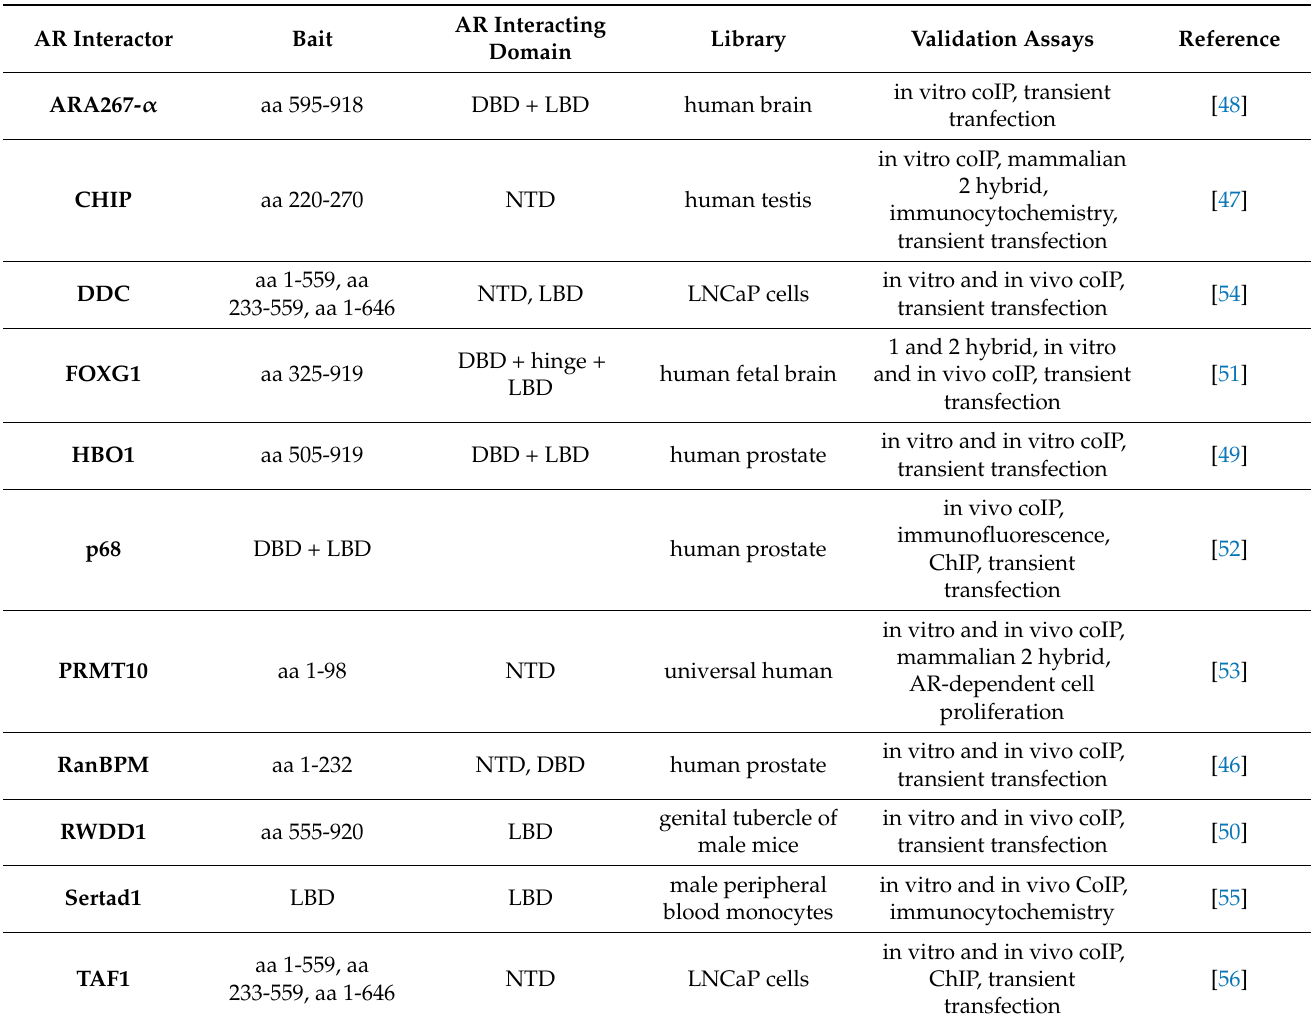
Table 1. Representative sample of AR interactors identified via 2 hybrid screening. For each AR interactor, the table shows the AR fragment or domain used as bait, the AR domain the prey preferentially interacts with, the cDNA library used in the assay, the assays used to validate interaction with AR and impact on AR function and the relevant literature report. Please note that numbering of amino acids (aa) reflects the numbers that were included in the original research